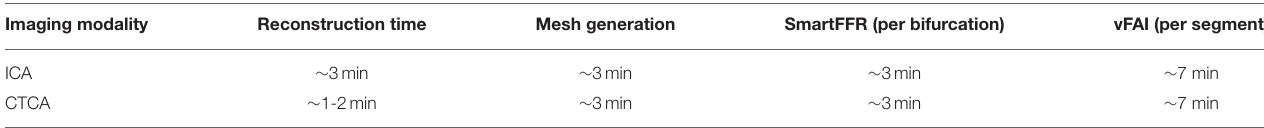
TABLE 2 | Average required time for SmartFFR and